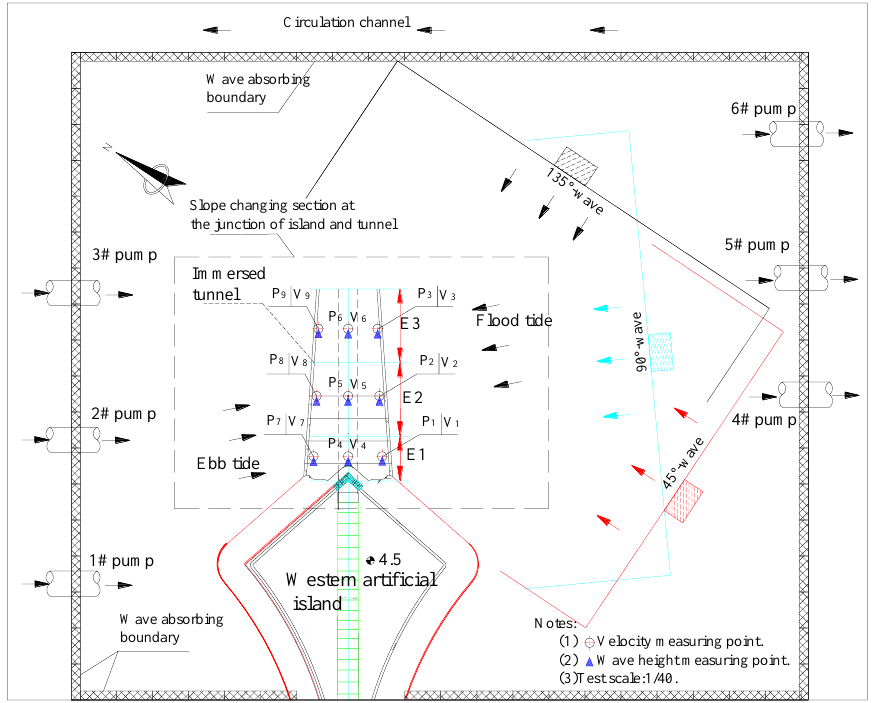
Figure 4. Layout of wave height and velocity measuring points.